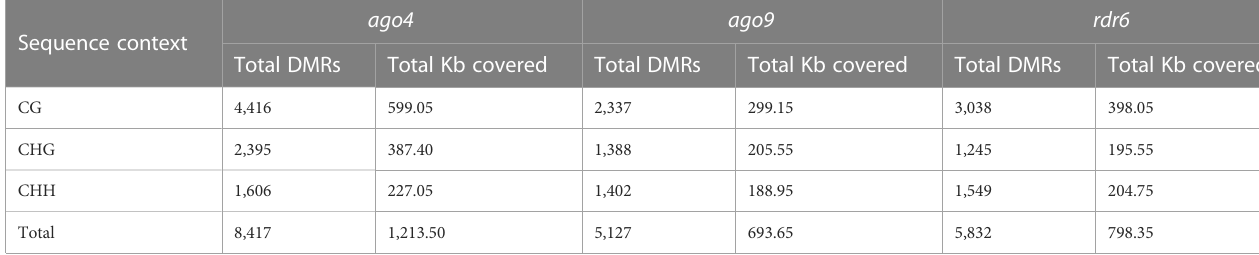
TABLE 1 Total number and length of DMRs in ago4 , ago9 and rdr6 .